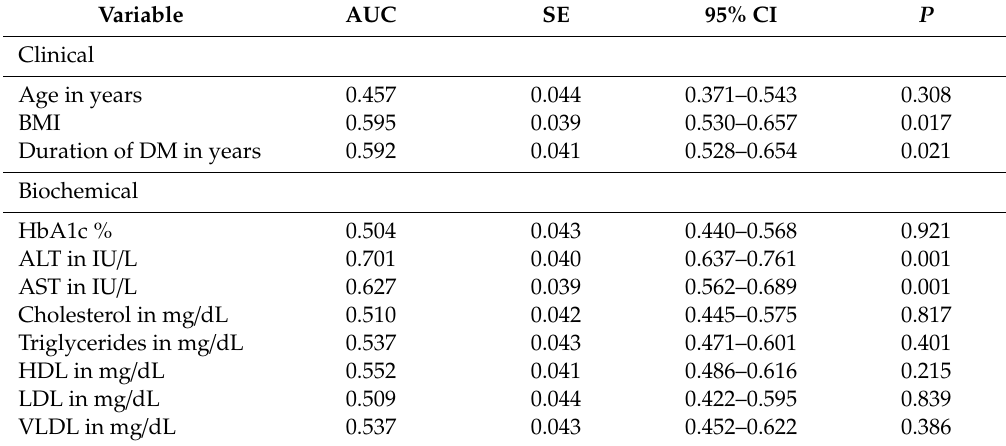
Table 2. Clinical and biochemical predictors of NAFLD among T2DM in Abha city.